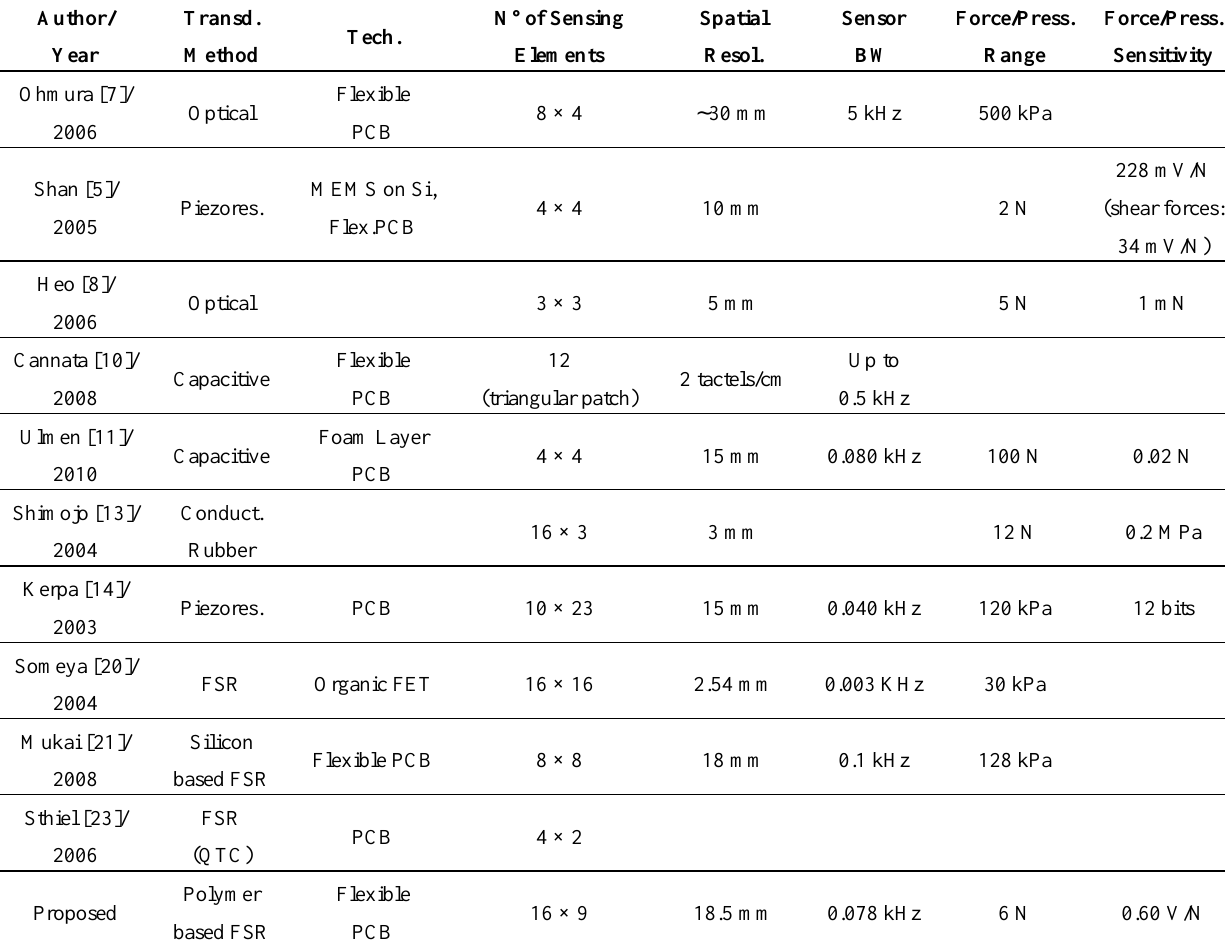
Table 3. Performance data from the proposed and other reported tactile sensor